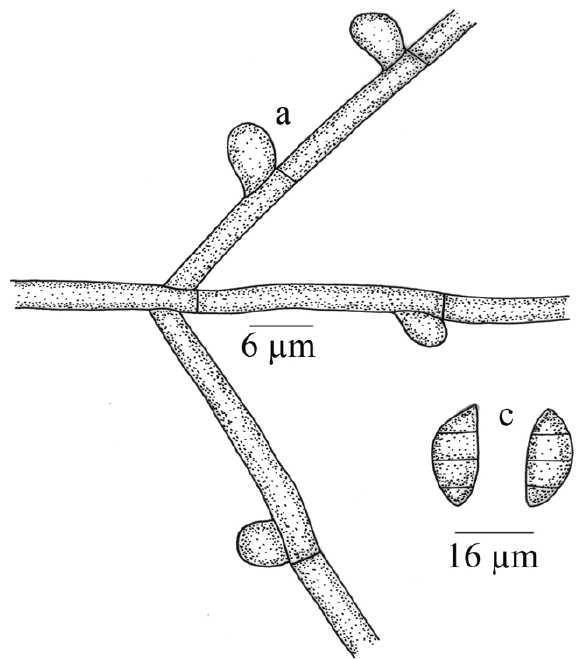
Figure 183. Questieriella sarcococcae a - Appressorium; b - Three septate